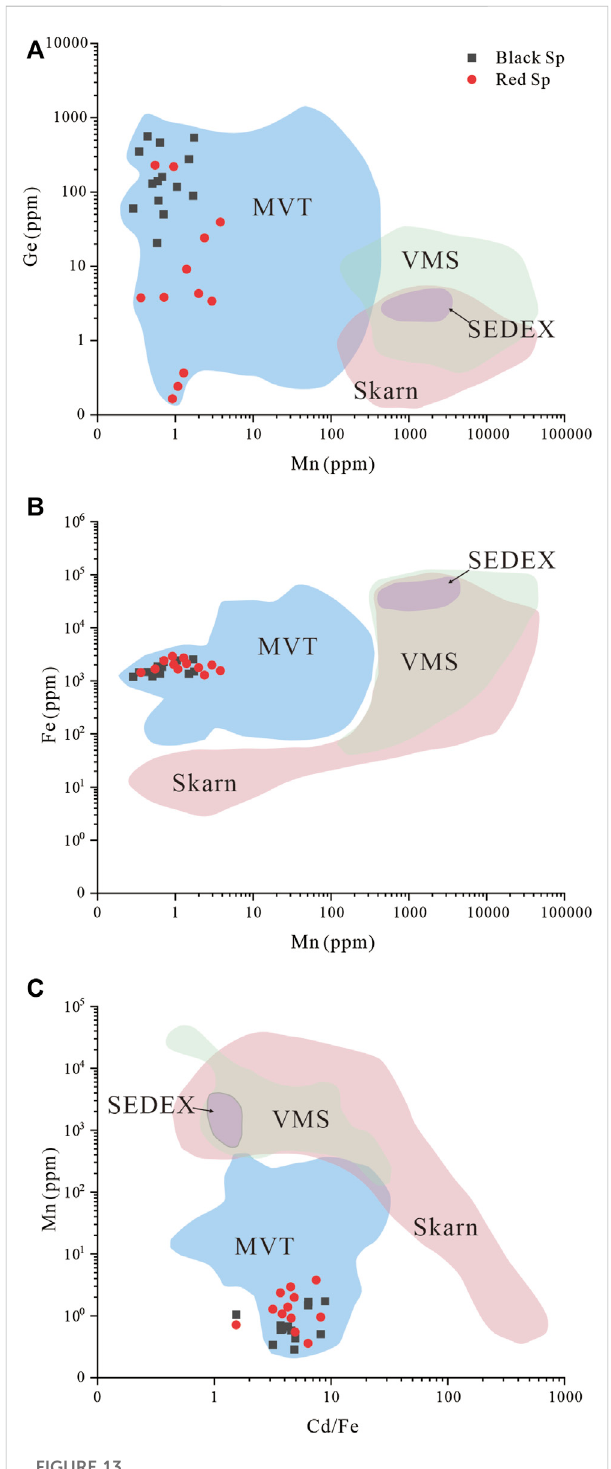
FIGURE 13 Binary plots of (A) Mn and Ge; (B) Mn and Fe; (C) Cd/Fe and